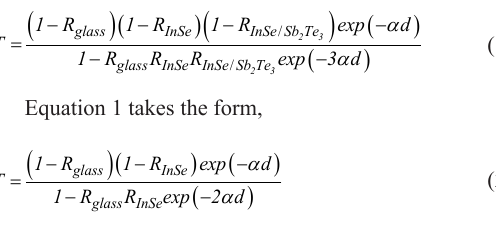
Figure 2. The optical (a) transmittance, (b) reflectance and (c) absorption coefficients spectra for InSe and InSe/Sb